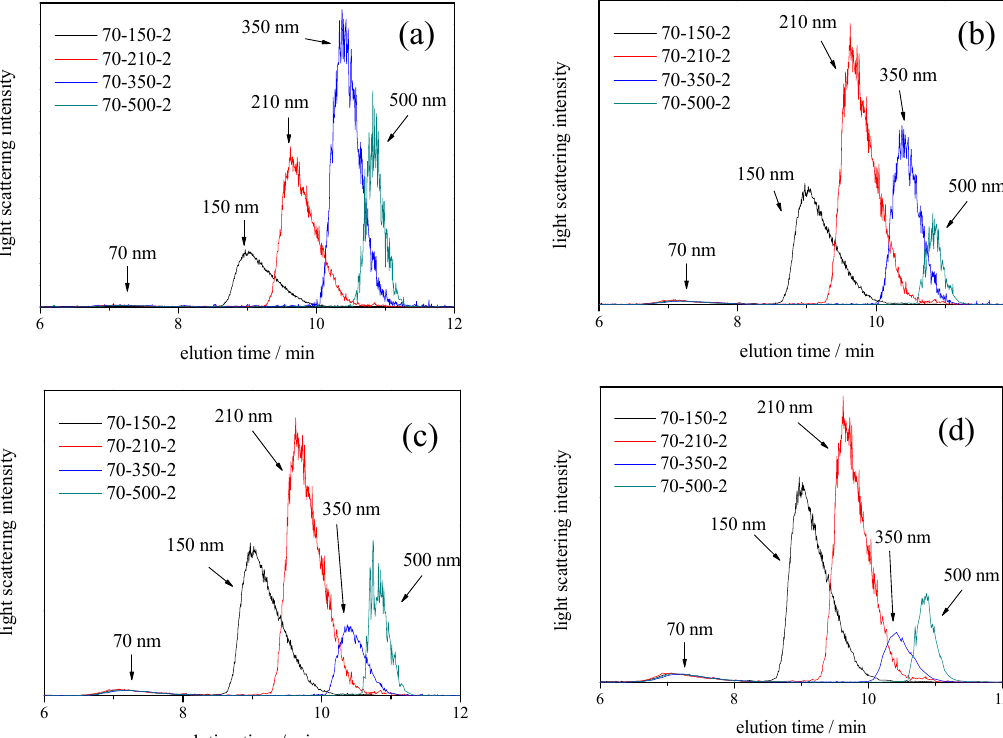
Figure 10. Fractograms observed at for mixed polystyrene latex particle suspensions by (fractionation measurements) AF4 separation. The channel flow rate was 1.0 mL/min and a cross-flow gradient of 2.0 mL/min to 0.0 mL/min over 30 min was used. 70-150-1 (black), 70-210-2 (red), 70-350-2 (blue), and 70-500-2 (green). Light scattering intensities were obtained by MALS; ( a ) observed at a detector angle of 60°; ( b ) observed at a detector angle of 90°; ( c ) observed at a detector angle of 121.2°; and ( d ) observed at a detector angle of 152.5°.